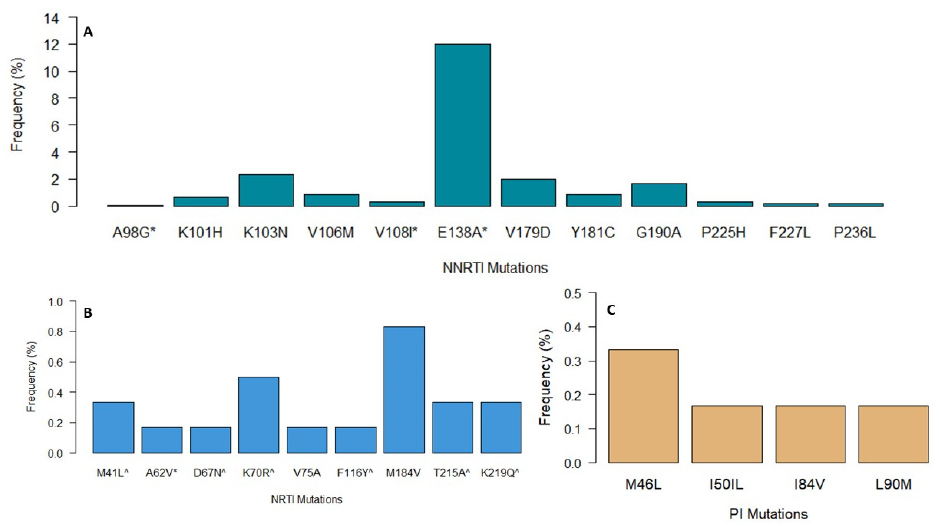
Figure 4. HIV-1 drug resistance mutations identified in the 602 sequences used for the analysis for the various antiretroviral drug classes ( A ) NNRTI, ( B ) NRTI, and ( C ) PIs, * polymorphic mutations (accessory mutations) and ^ Thymidine Analog Mutations (TAMs).